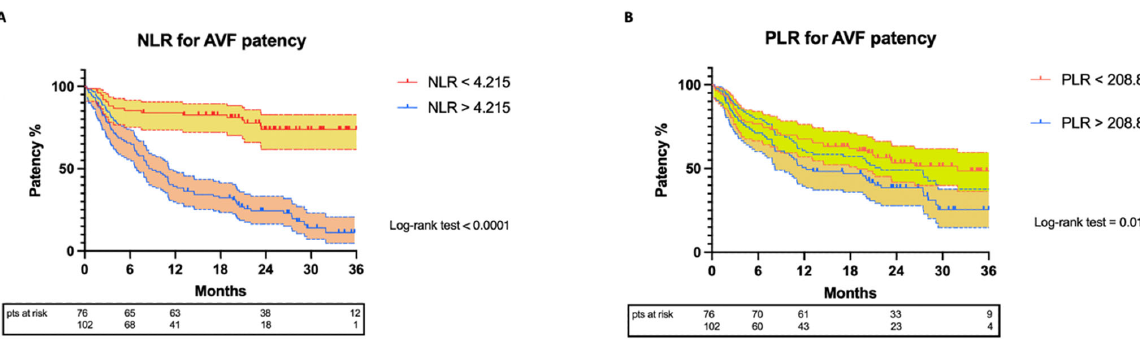
Figure 4. Kaplan–Meier curves representing: ( A ) arterio-venous fistula patency based on NLR cut-off value; ( B ) arterio-venous fistula patency based on PLR cut-off value. Color-filled areas represent the standard error.